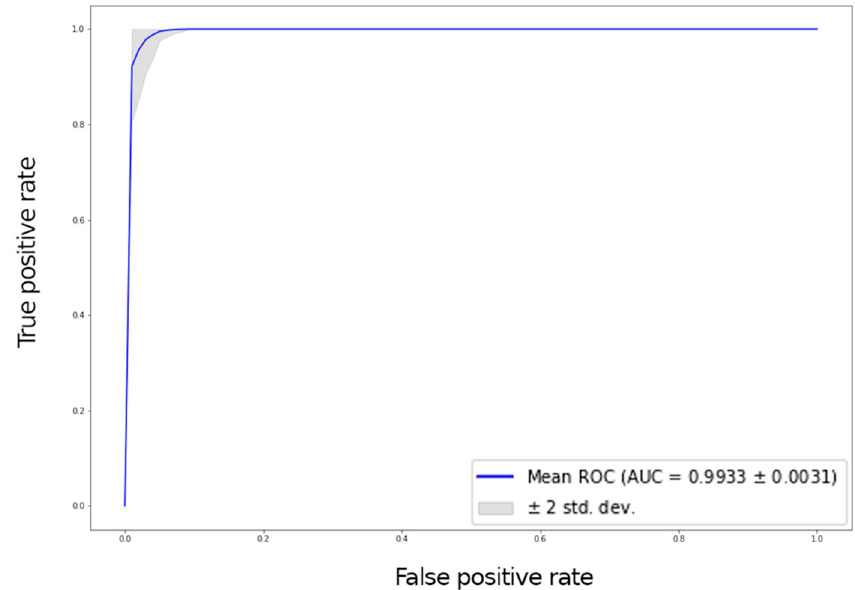
Figure 4. ROC curve with a 95% confidence interval (grey area) for the test set.